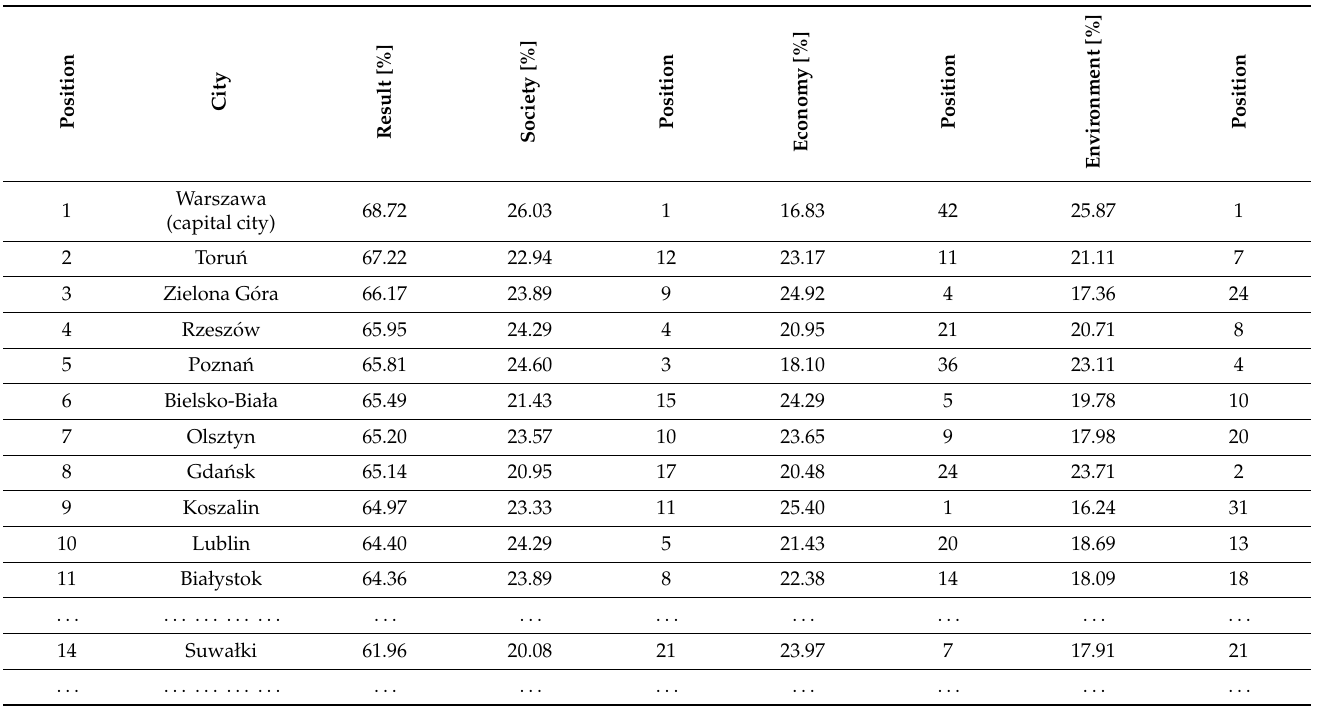
Table 3. Overall classification broken down by development areas of the Ranking of Polish Sustainable Cities Arcadis 2021.